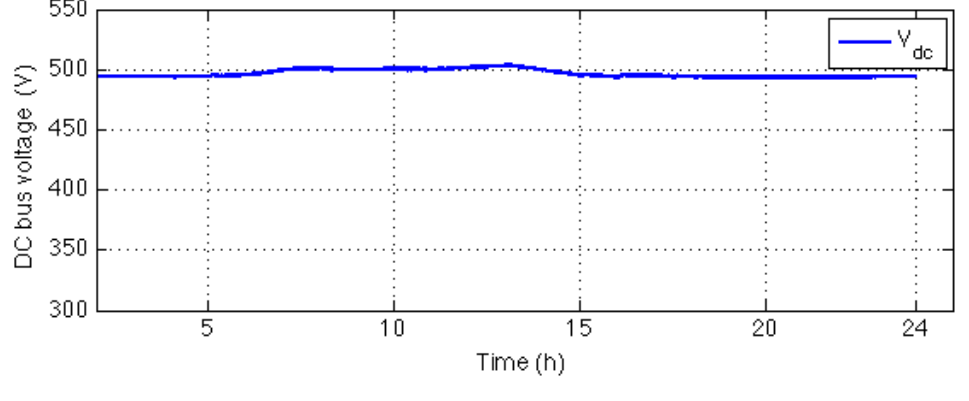
Figure 11. DC bus voltage.